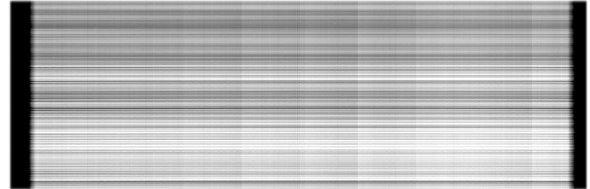
Figure 9. Example of rectified AMETHIST PA image (central array, IAZ are visible on both sides)